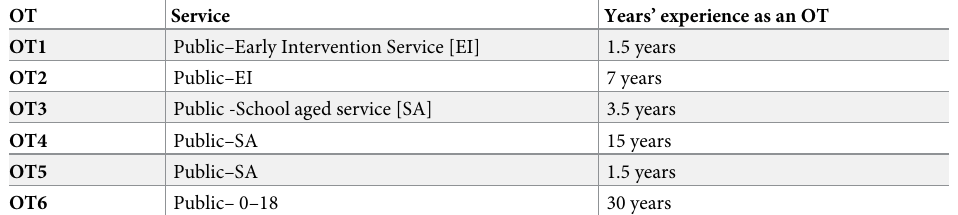
Table 3. Occupational Therapist (OT) participants.